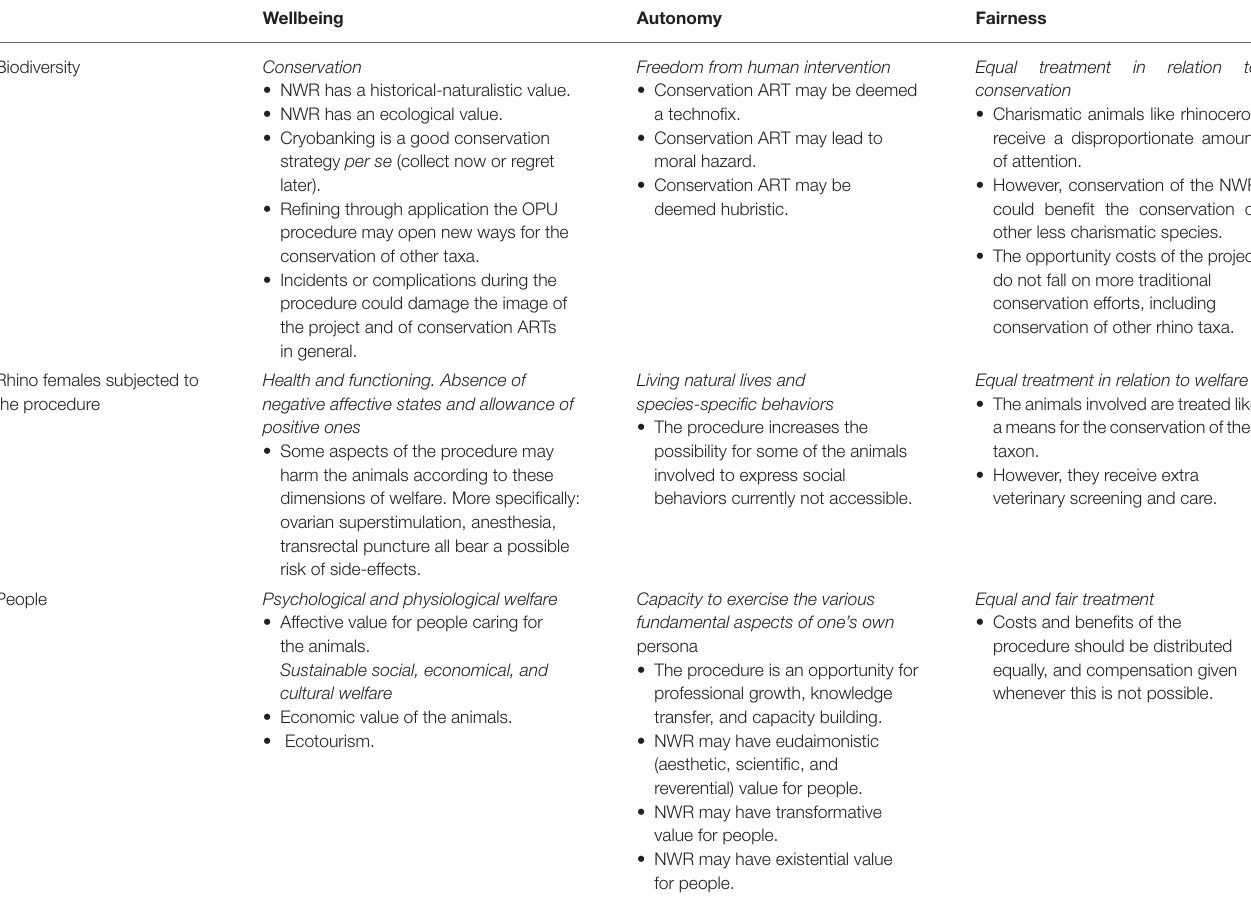
TABLE 4 | EM for OPU in NWR conservation